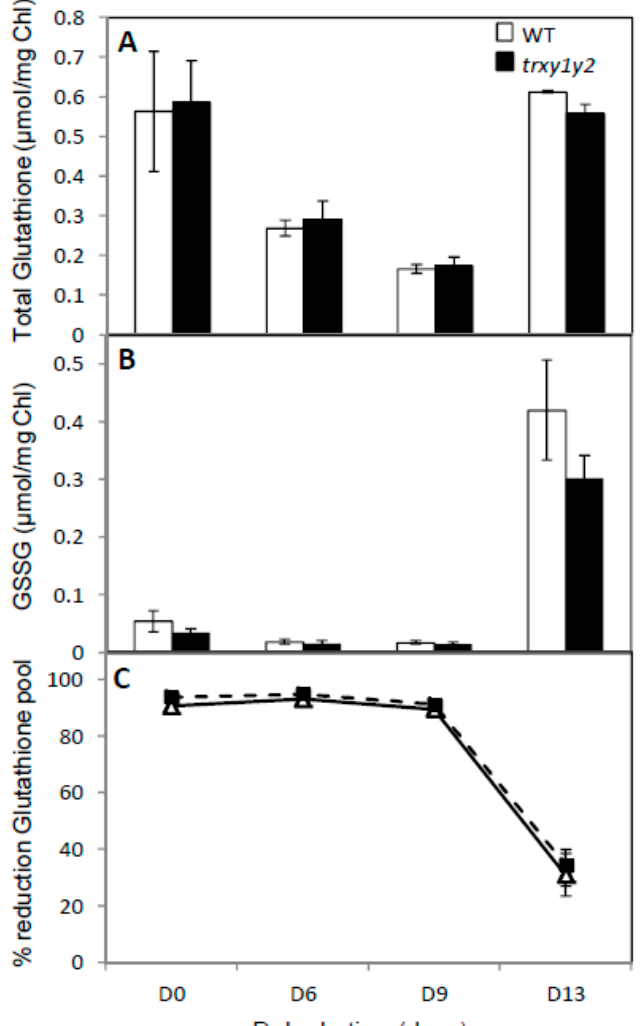
Figure 5. Effect of drought on leaf glutathione pool size and redox state. Glutathione pool after dehydration in WT (open column or triangle) and in trxy1y2 mutant (dark column or square) leaves. ( A ) Total glutathione content; ( B ) GSSG content; ( C ) redox state of the glutathione pool. Data correspond to means ± SD ( n = 4, from 2 independent experiments).